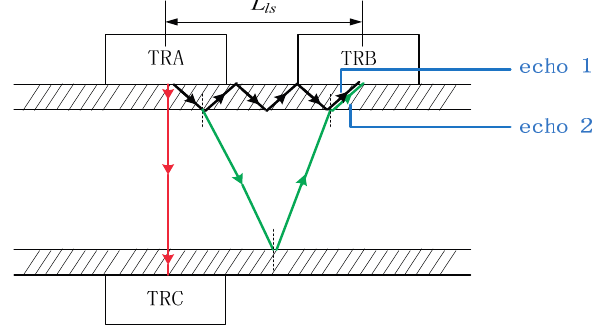
Figure 1. Schematic diagram of the ultrasonic propagation